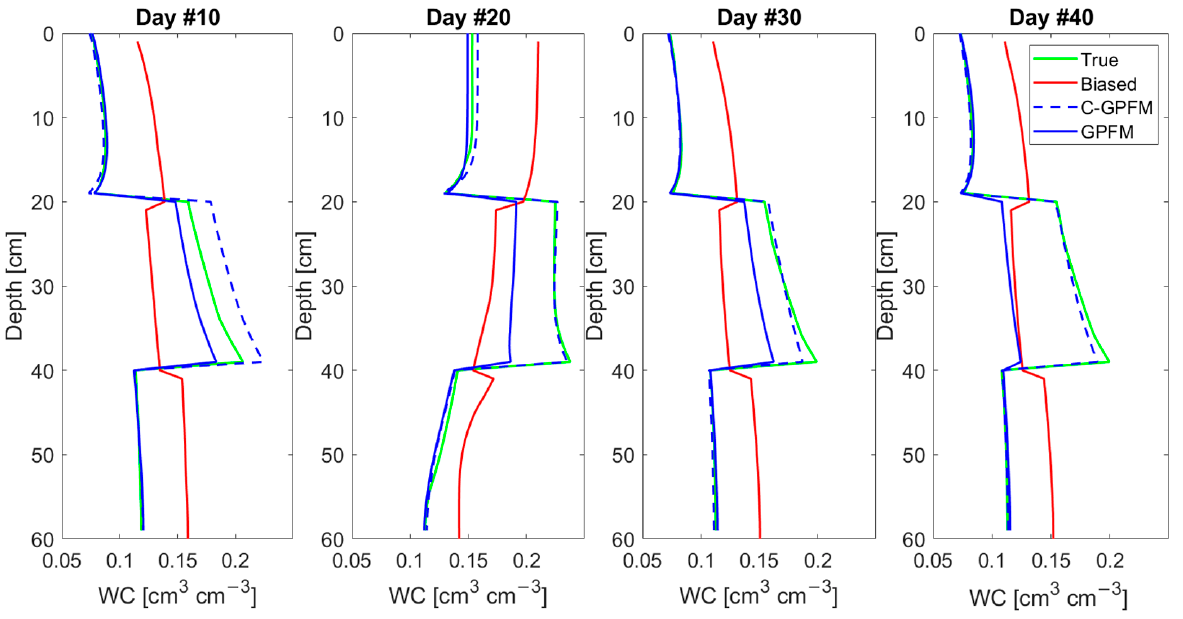
Figure 5. Average of parameters posteriors by C-GPFM and GPFM at days #10, #20, #30 and #40 for Case Study #1.